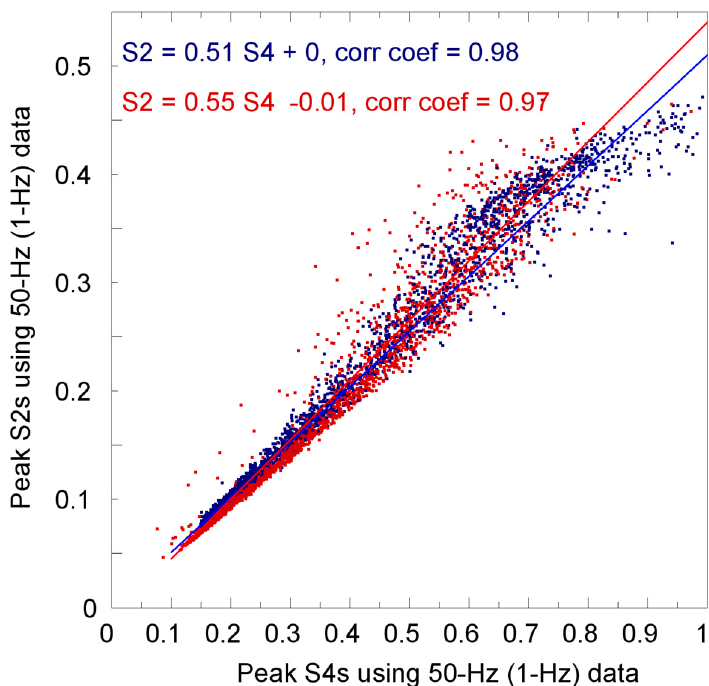
Figure 8. Scatter plot for the peak S 2 values measured using 50 Hz (1-Hz) data versus the peak S 4 values measured using 50 Hz (1-Hz) data is shown in blue (red). Two corresponding least-squares fitting lines, line equations, and the obtained correlative coefficients are also shown. As in Figure 7, the experimental FS3/COSMIC data were obtained on 1 January and 1 July